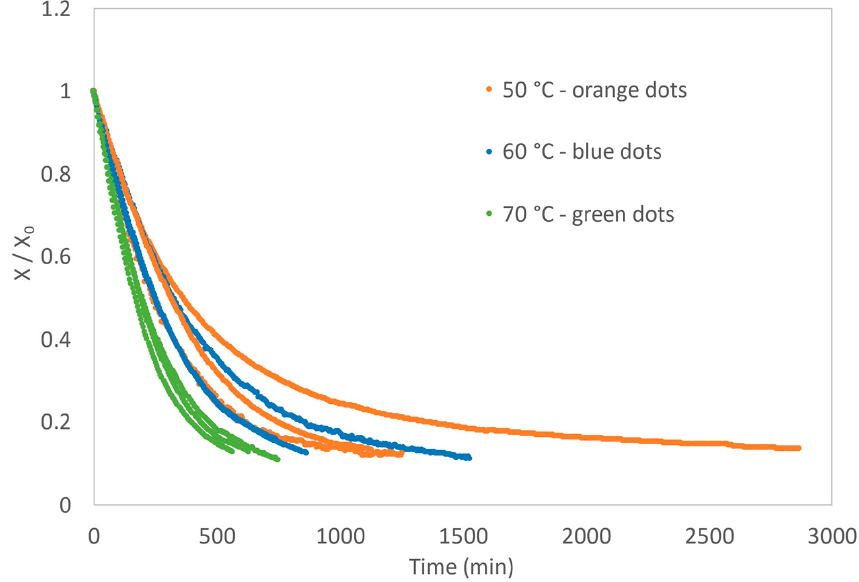
Figure 2. Normalised experimental data of the three replicates for the three tested drying tempera- tures.